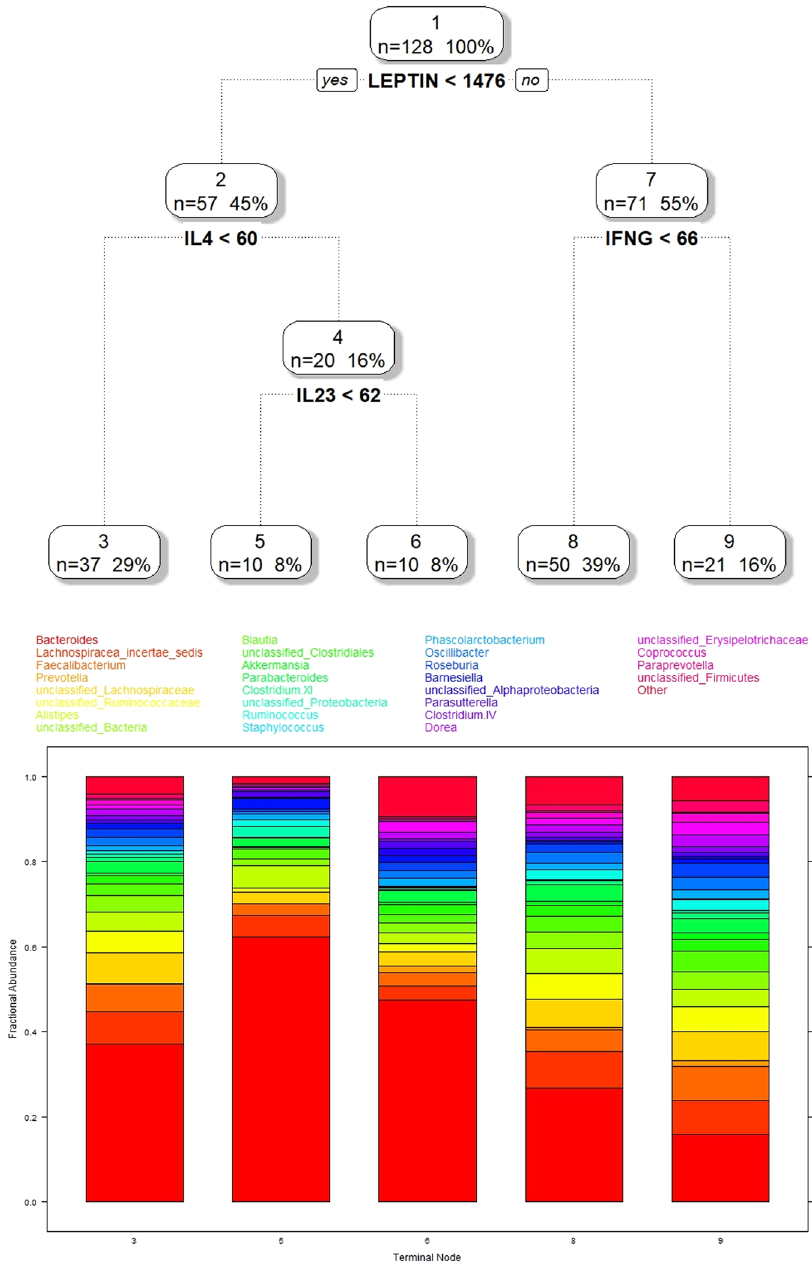
Figure 1. Results of applying DM-RPart to the iHMP microbiome and cytokine data. 1( A ) (top) shows the optimal tree found by fitting the full tree and using cross-validation pruning to find the best fitting tree. 1( B ) (bottom) shows the taxa frequency composition differences for the 5 terminal